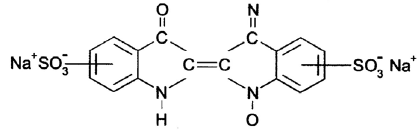
FIGURE 1 - Chemical structure of indigo carmine